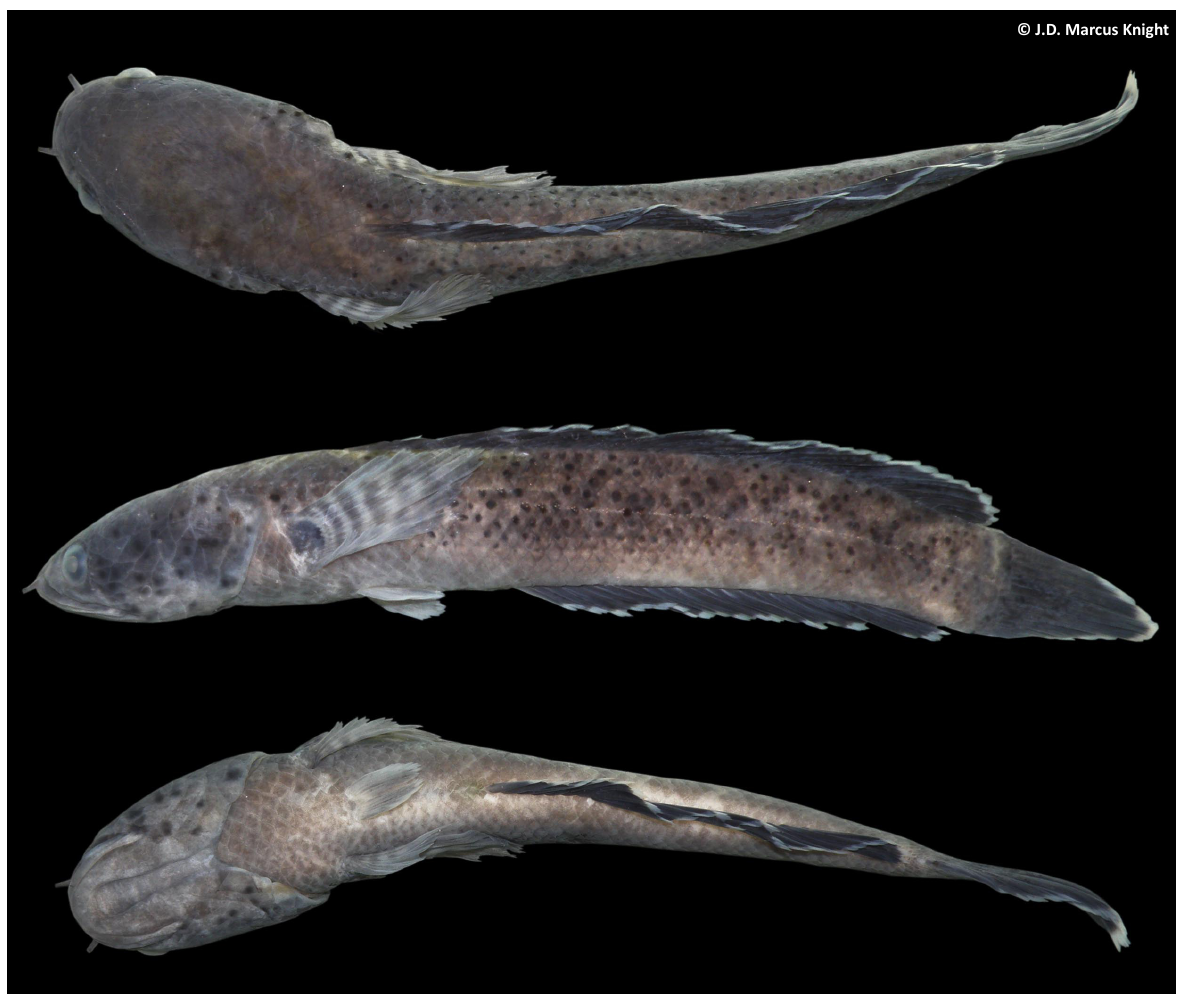
Colouration In alcohol (Image 1), dorsum, sides of head and body uniformly dark grey gradually becoming lighter towards the throat and abdomen. Fifteen to twenty well defined black spots on the post-orbital region of the head, opercle and with numerous black spots along the flanks extending into the dorsal fin and caudal fin, which sometimes fade to become dark grey and on prolonged preservation become inconspicuous. Dorsal, anal and caudal fins dark grey with a broad white and black margin. Pectoral fin cream with three or four dark grey semi-circular bands. Pelvic fin grey with a white margin. Live specimens (Image 2A) are bluish-grey in colour; top of the head and opercular region bright blue. 15–20 well defined black spots on the post-orbital region of the head and opercle. Body with bluish dorsum gradually becoming grey towards the abdomen, with